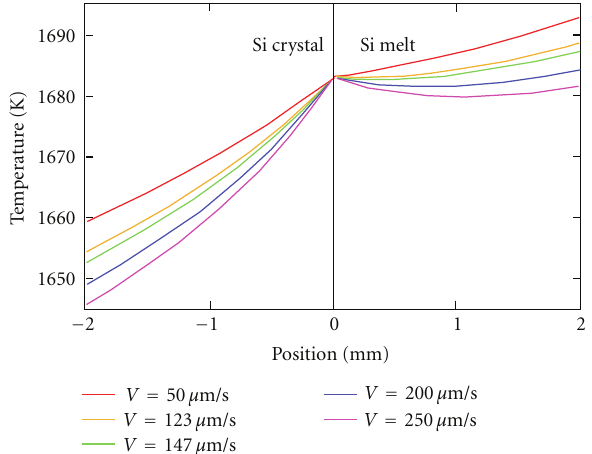
Figure 5: Calculated thermal fields of Si crystal and melt during crystallization for V (cid:2) 50, 123, 147, 200, and 250 μ m/s. ρ c C Pc = 2 . 29 × 10 − 3 J/mm 3 K, ρ m C Pm = 2 . 53 × 10 − 3 J/mm 3 K, k c = 2 . 2 × 10 − 2 W/mmK, k m = 5 . 4 × 10 − 2 W/mmK, k q = 4 . 3 × 10 − 3 W/mm K, l q (cid:2) 1.0mm, l Si (cid:2) 0.5 mm, G (cid:2) 8 K/mm, Δ H = 4 . 122 J/mm 3 , and T mp (cid:2) 1683 K. l q , l Si , and G are based on the